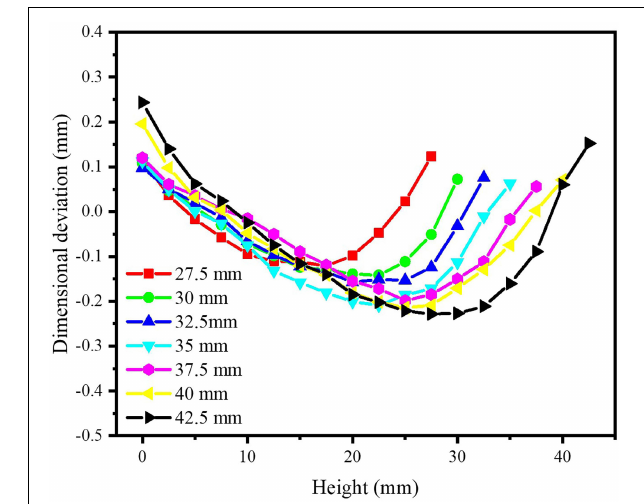
FIGURE 9 | Dimensional deviation at the trailing edge.